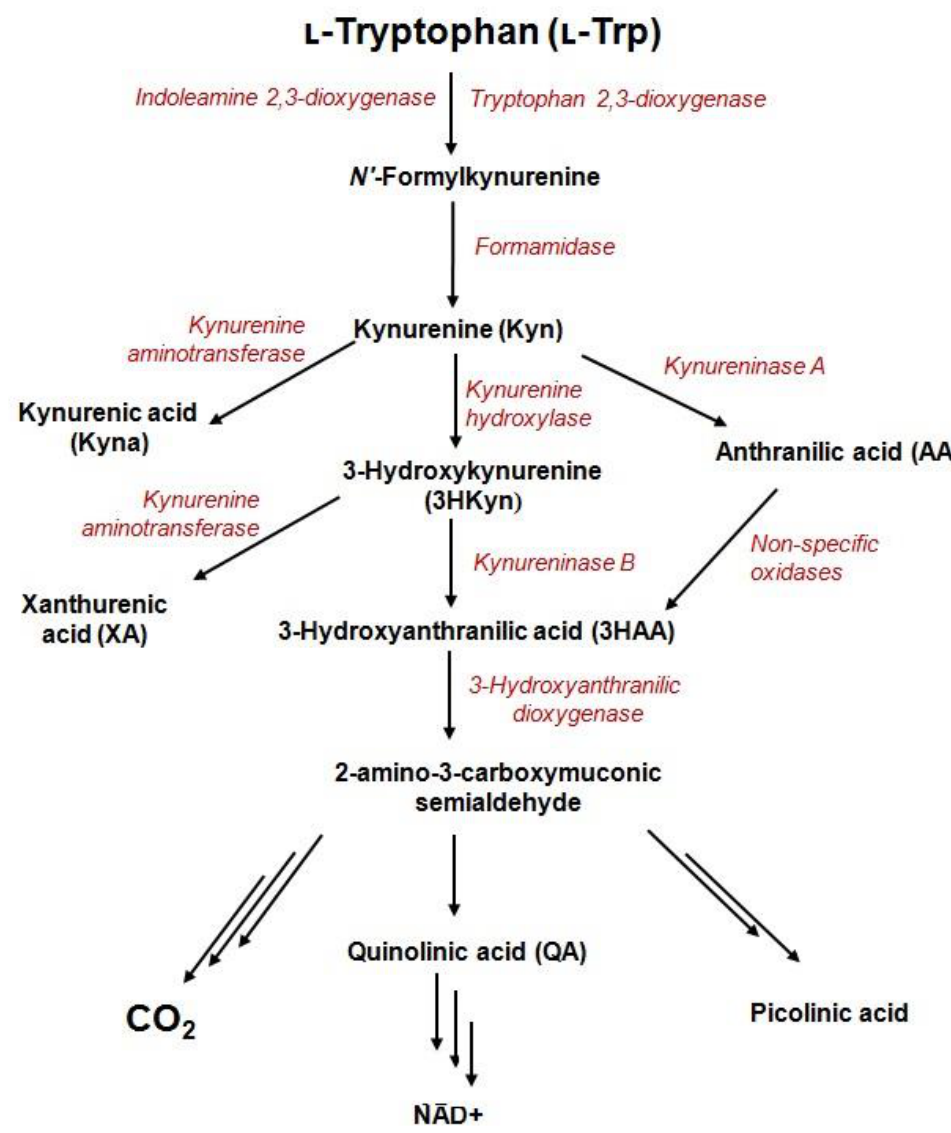
Figure 1. Metabolites and enzymes of the kynurenine pathway.